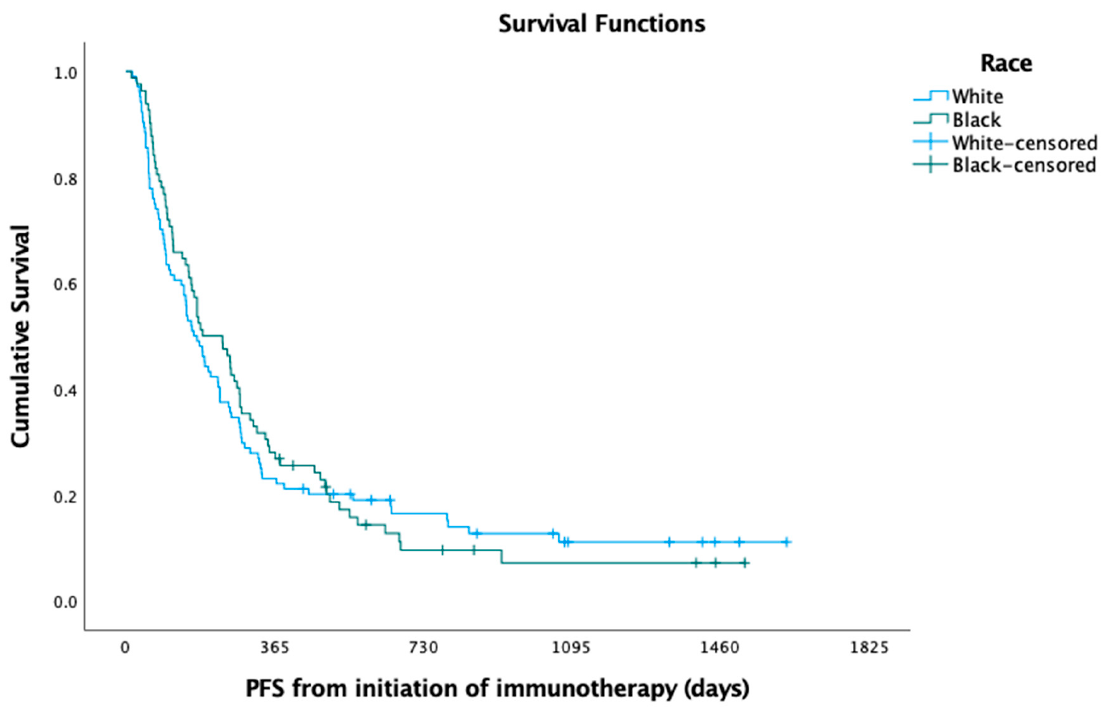
Figure 1. Progression-free survival (PFS) among black versus white patients.